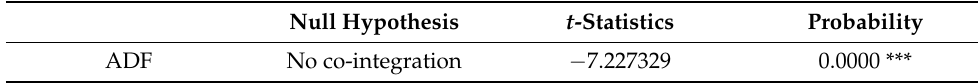
Table 6. The results of Kao’s residual panel cointegration test (ADF). Null Hypothesis t -Statistics Probability ADF No co-integration −